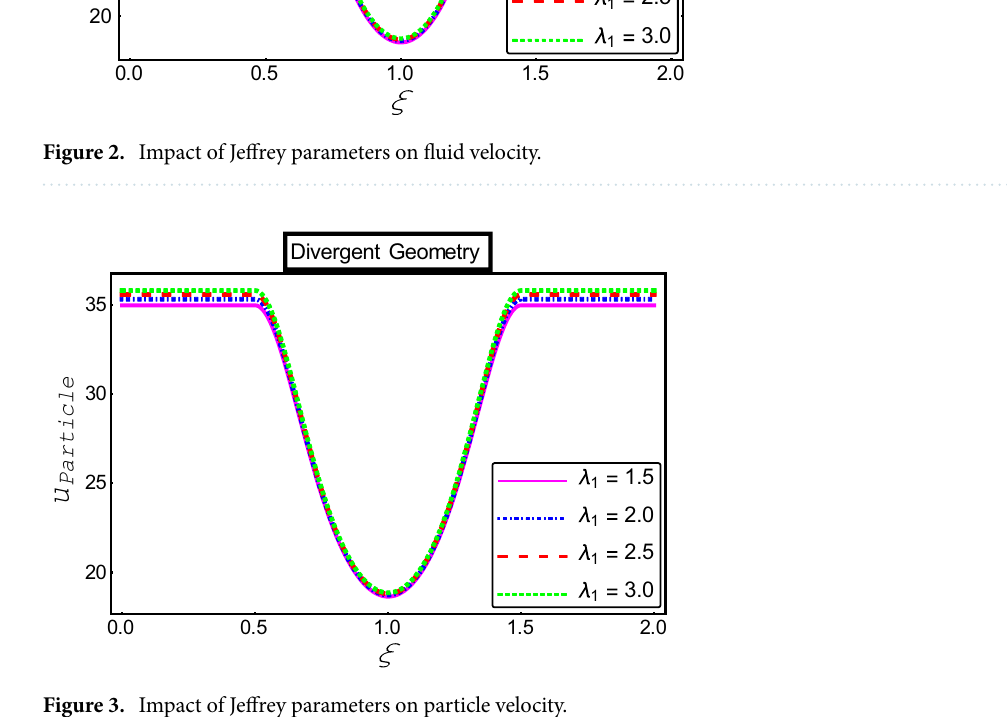
Figure 3. Impact of Jeffrey parameters on particle